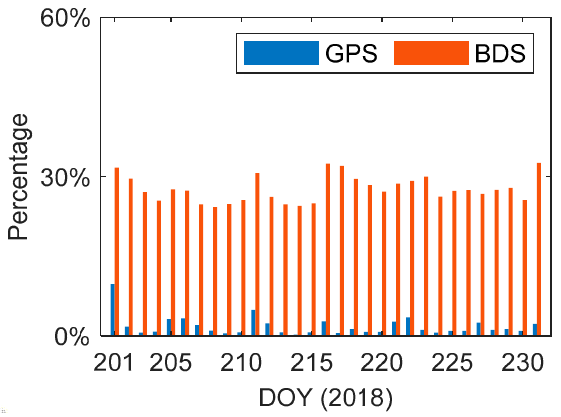
Figure 6. CSES’ onboard GPS ( blue ) and BDS ( red ) data loss percentage for each POD arc from DOY 201 to DOY 231, 2018. The X-axis represents the first day of one POD